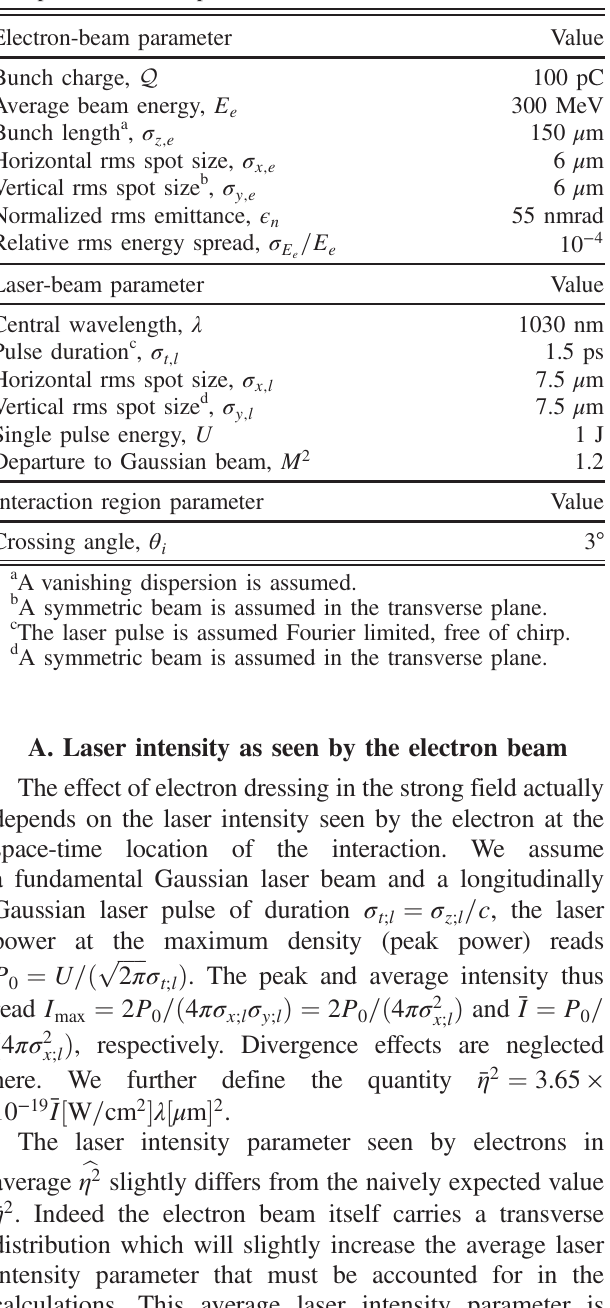
TABLE I. Electron, laser, and interaction region parameters for the numerical benchmark of the analytical expression derived in this paper. The electron-beam parameters are inspired from Refs. [8,19]. The beam parameters values refer to those at the Compton interaction